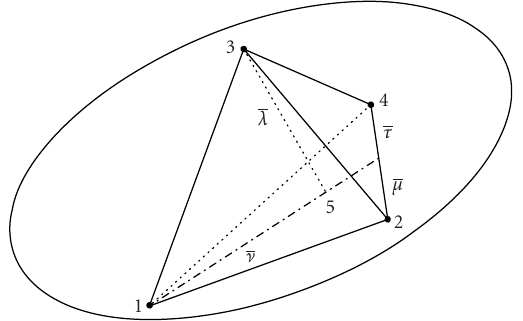
Figure 2.2. The rigid body system with its equivalent primary particles indicating the invariant quan-